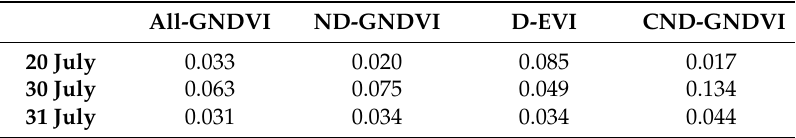
Figure 3. Measured FPAR and predicted FPAR of four models for ( a ) a cloudy nondrought day, ( b ) a sunny drought day, and ( c ) a sunny nondrought day. Table 6. The RMSE values for the predicted FPAR and the measured